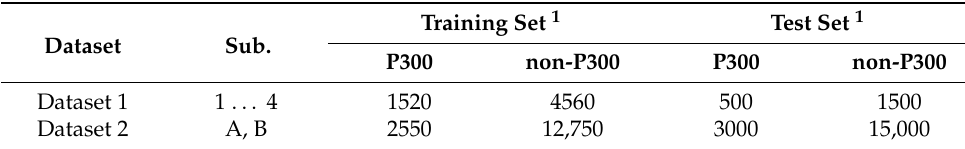
Table 1. Training and test datasets composition.